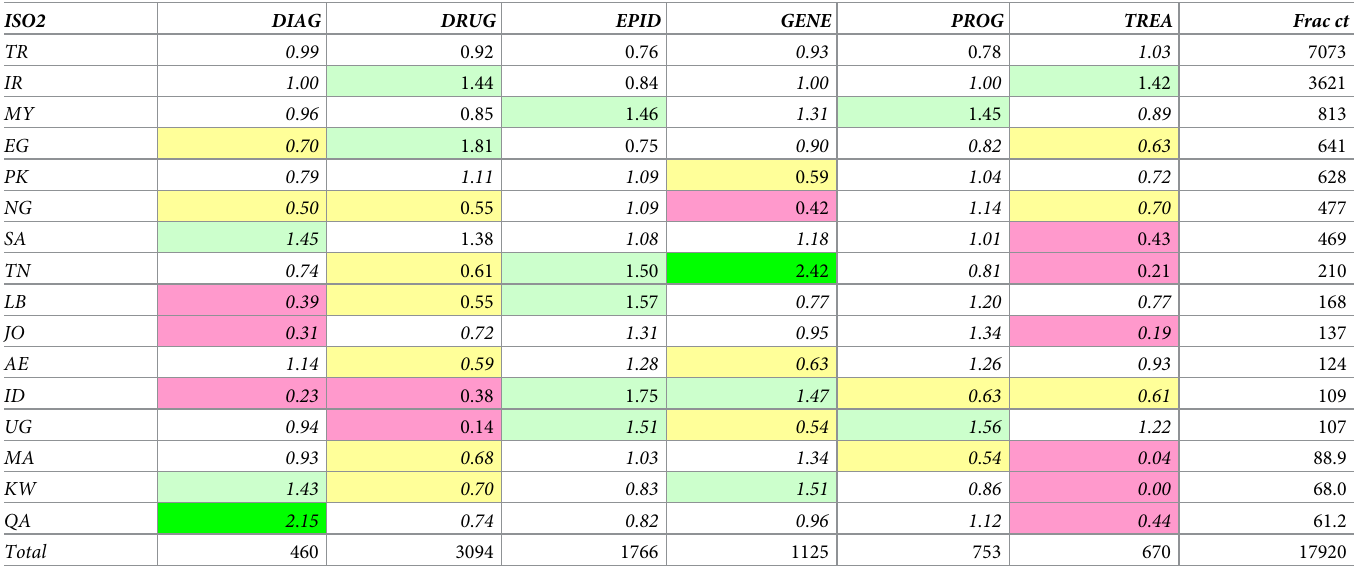
Table 7. Relative commitment within mental health disorders research to work on six research types (codes in Table 3) by the leading 16 countries (codes in Table 1), 2008–17, fractional counts. ISO2